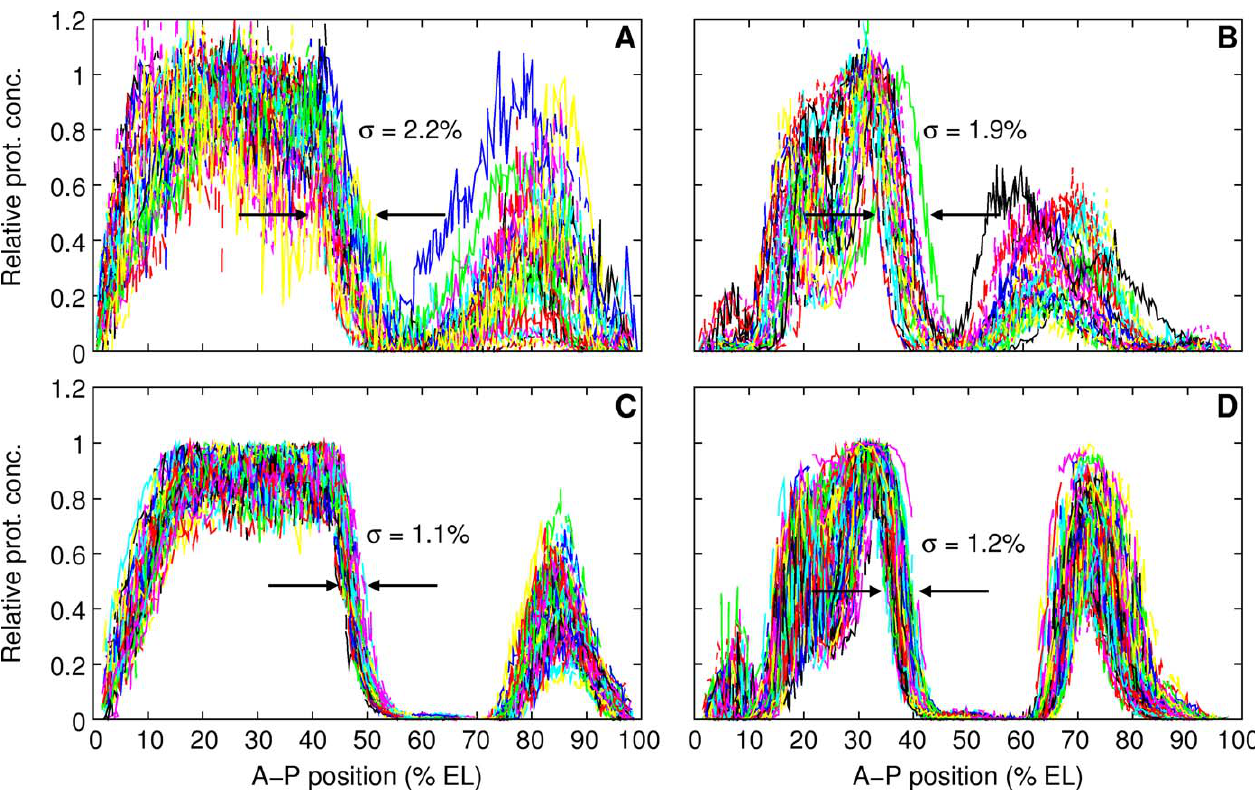
Figure 6. The Control of Positional Variation of the Posterior Border of the Anterior hb Domain by Kr and Kni hb (A) and gt (B) expression profiles in 28 Kr ; kni double mutant embryos from time classes T4–T7 (Table 1); r Hb ¼ 2.2% EL (standard deviation) and q Hb ¼ 9.3% EL (range). The standard deviation of the posterior border of the third gt domain is r Gt ¼ 1.9% EL; q Gt ¼ 8.9% EL. hb (C) and gt (D) expression profiles in wild-type embryos of the same age as in (A) and (B). r Hb ¼ 1.1% EL and q Hb ¼ 5.6% EL (68 embryos). r Gt ¼ 1.2% EL and q Gt ¼ 5.6% EL (92 embryos). Expression patterns are shown normalized against the maximum level (see Methods) in the anterior hb (A and C) or the anterior gt (B and D) domains.